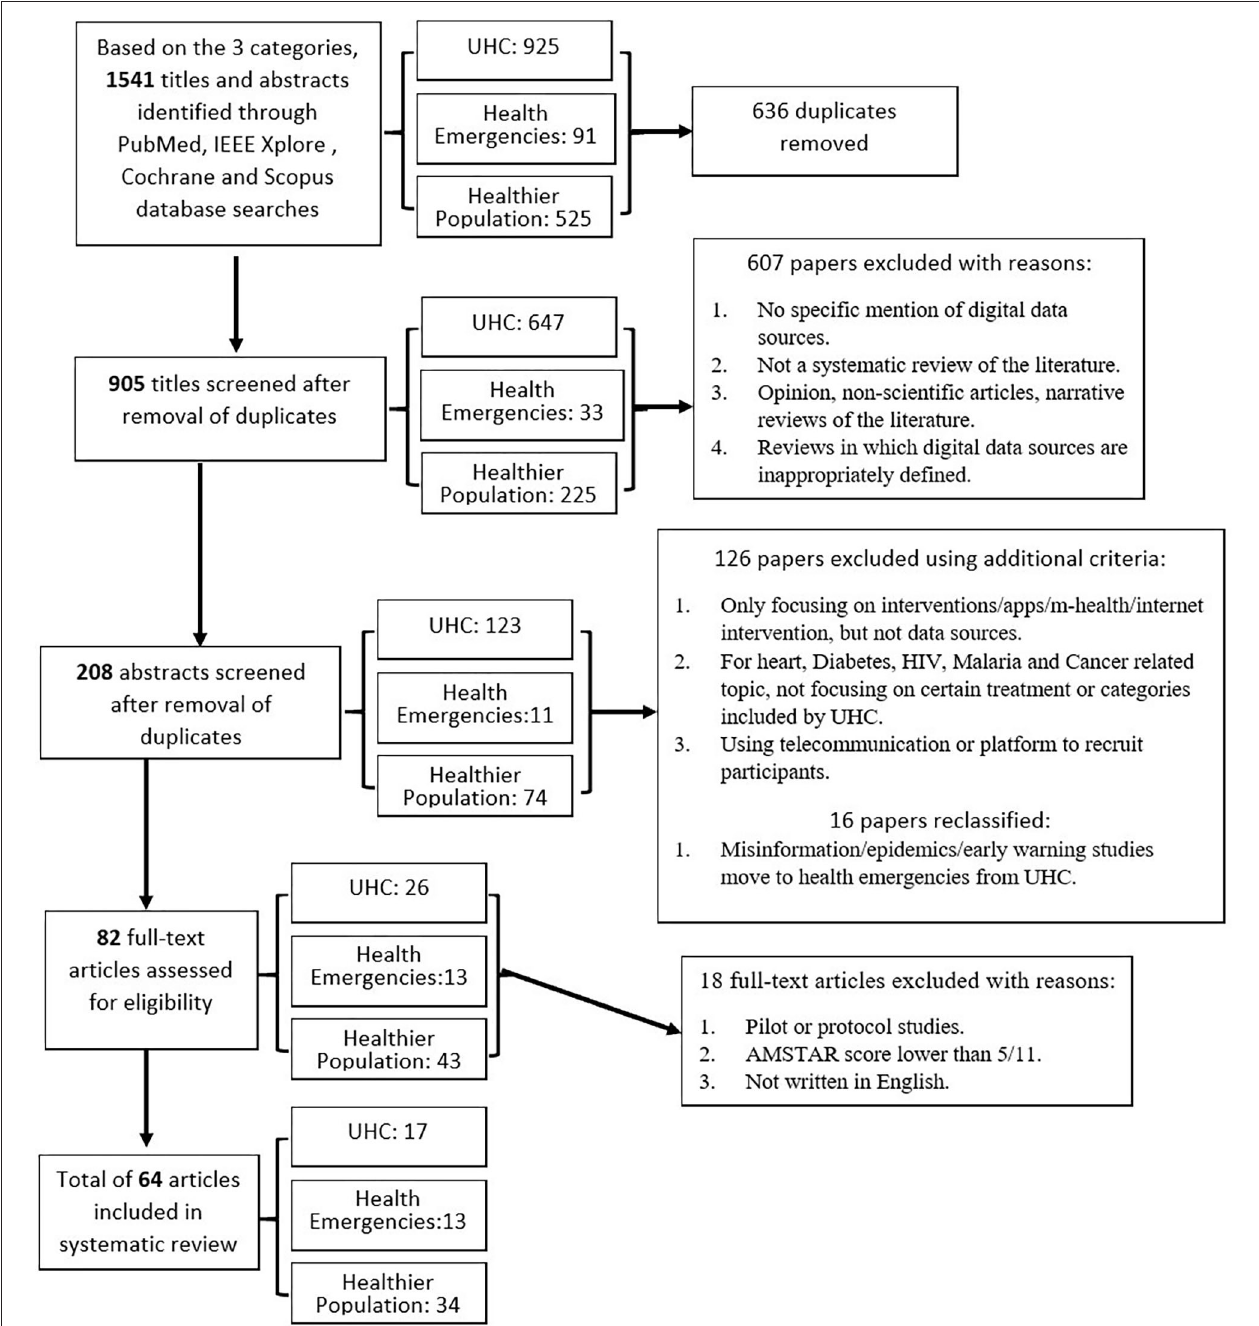
FIGURE 3 | PRISMA diagram detailing the study identification and selection